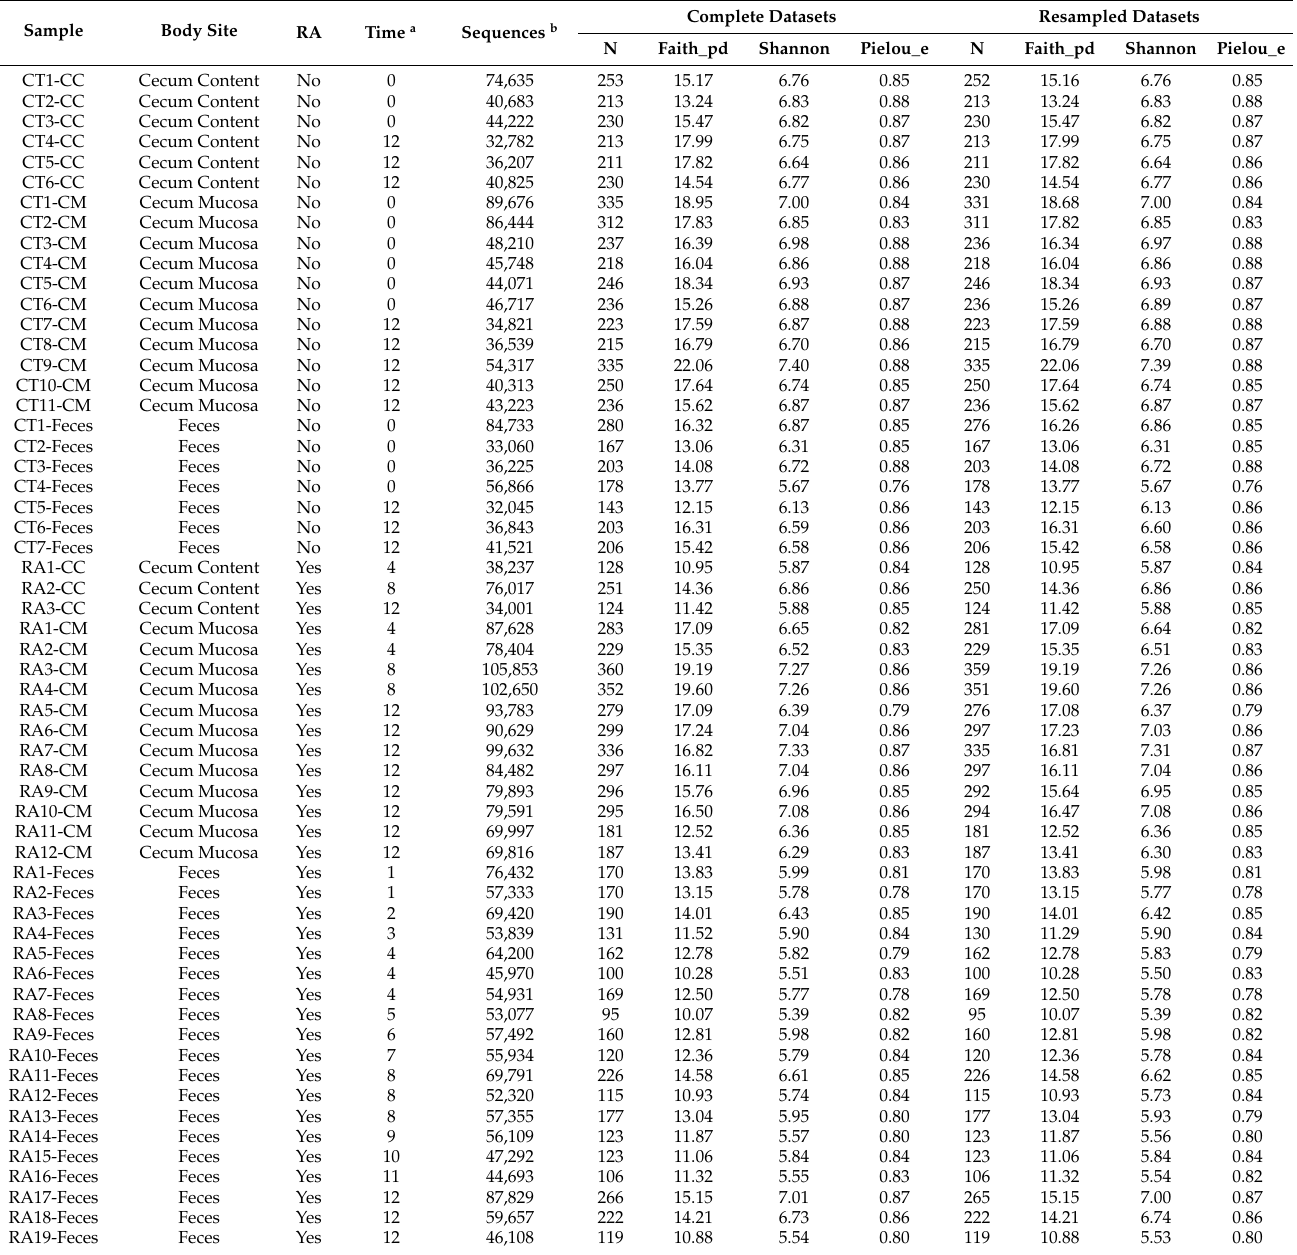
Table 1. Alpha-biodiversity for the complete datasets and the resampled datasets based on an equal number of 31,794 sequences per sample (the lowest one corresponding to